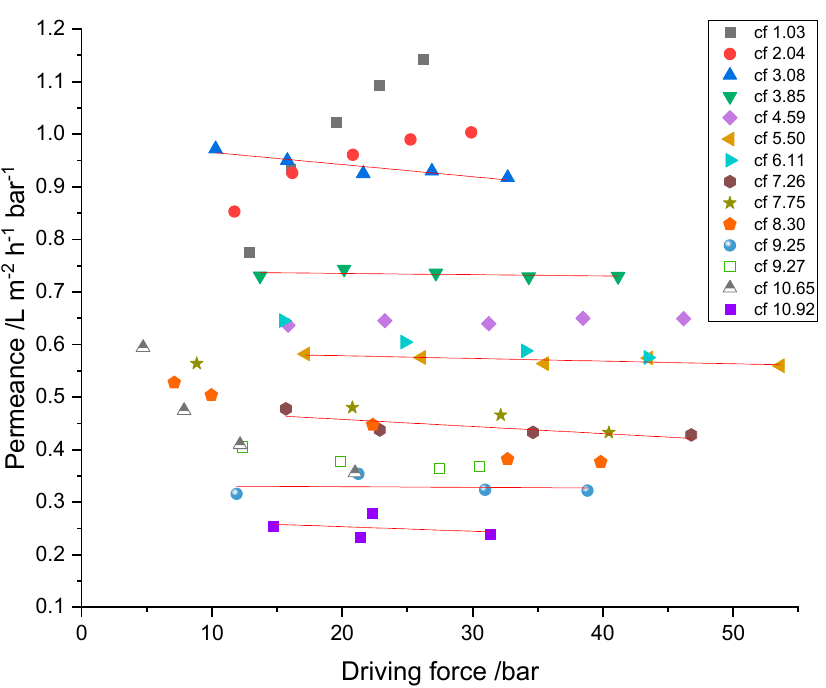
Figure 9. Membrane permeance at different feed concentrations corresponding to different Cr concentration factors (cf) in relation to the driving force. Linear regression lines are shown for visual guidance.